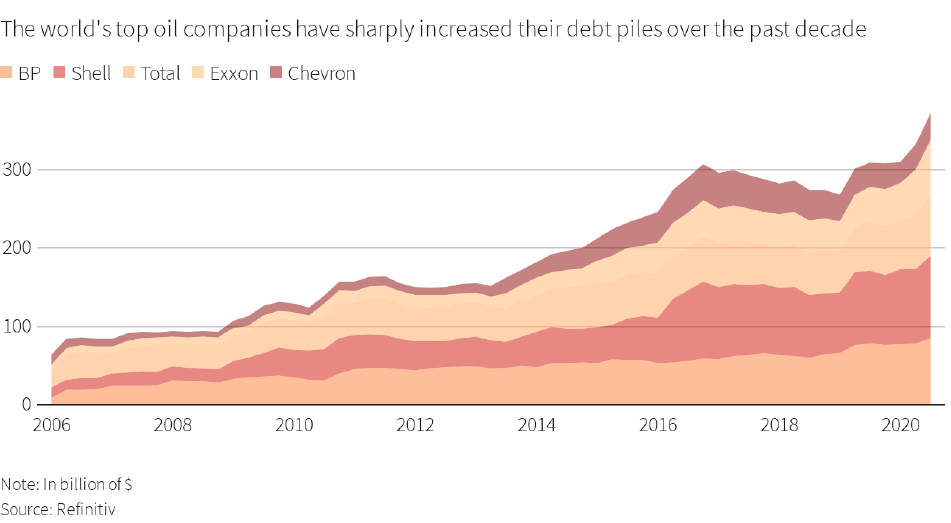
Figure 16. The soaring debt of the oil majors. Source: Refinitiv, an LSEG business, Reproduced with permission from Reuters [165].